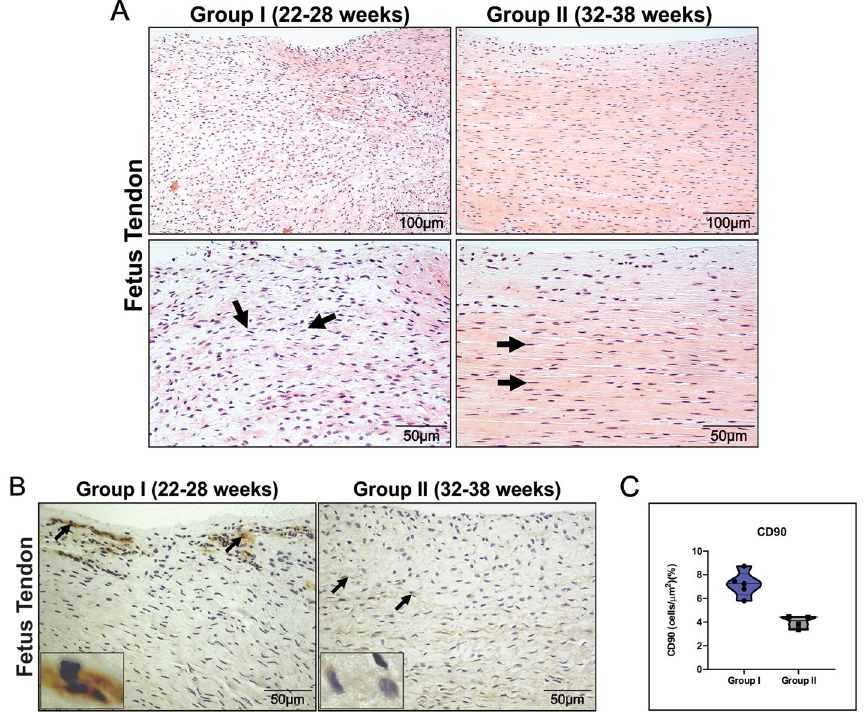
Figure 2. Cell distribution in human fetal tendons. ( A ) Cell distribution in human fetal tendons—Human fetal tendon samples from Group I (22–28 weeks; n = 5) and Group II (32–38 weeks; n = 4) show